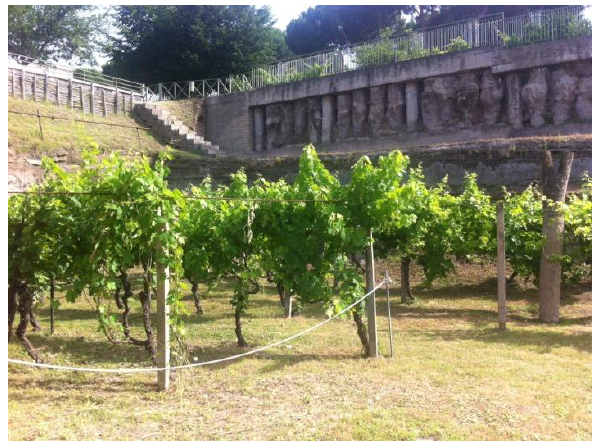
Figure 9a, 9b e 9c. Autochthonous Boscoreale's vine